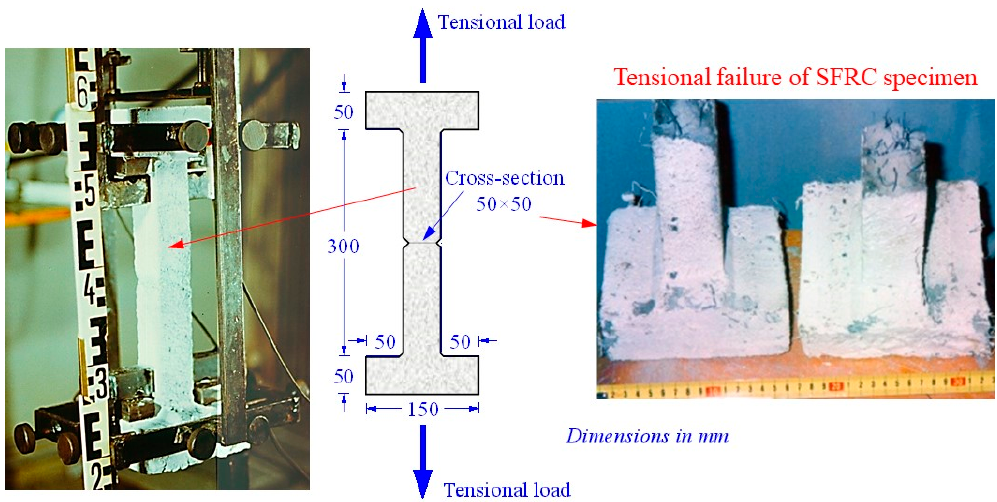
Figure 2. Prismatic SFRC specimen tested and failed under axial tension test. Materials 2020 , 13 , 2923 8 of 30